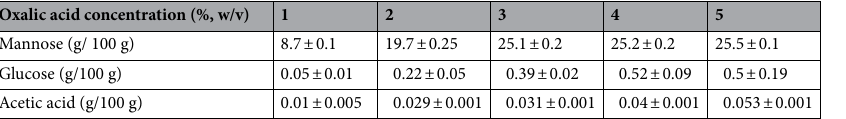
Table 1. Mannose, glucose and acetic acid released from pretreated PKC at different oxalic acid concentration.